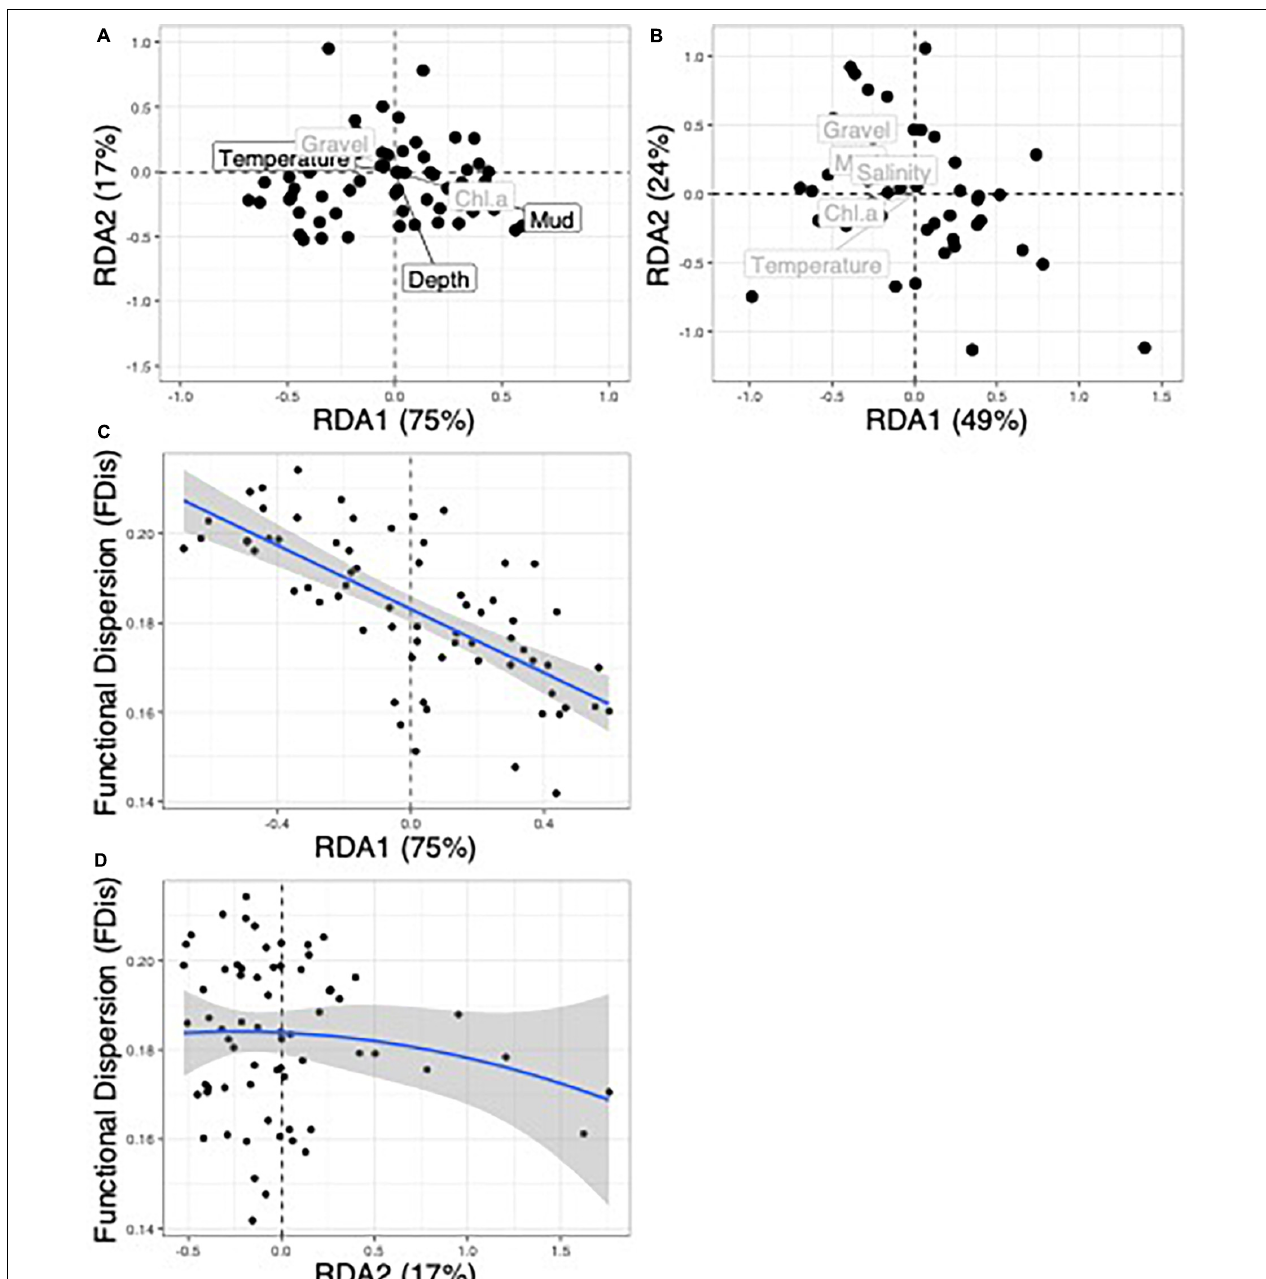
FIGURE 7 | Community-weighted-mean redundancy analysis (CWM-RDA) of functional traits and environmental variables in the Chukchi Sea (A) and the Beaufort Sea (B) . Length of vectors represent the loadings of environmental variables. The relationship of functional dispersion (FDis) with environmental gradients via a generalized-least-squares polynomial linear model is shown for the Chukchi Sea for the first CWM-RDA axis (from left to right along the RDA axis) representing high percent mud to high temperature (C) and for the second axis (from bottom to top) representing a decreasing depth gradient (D)